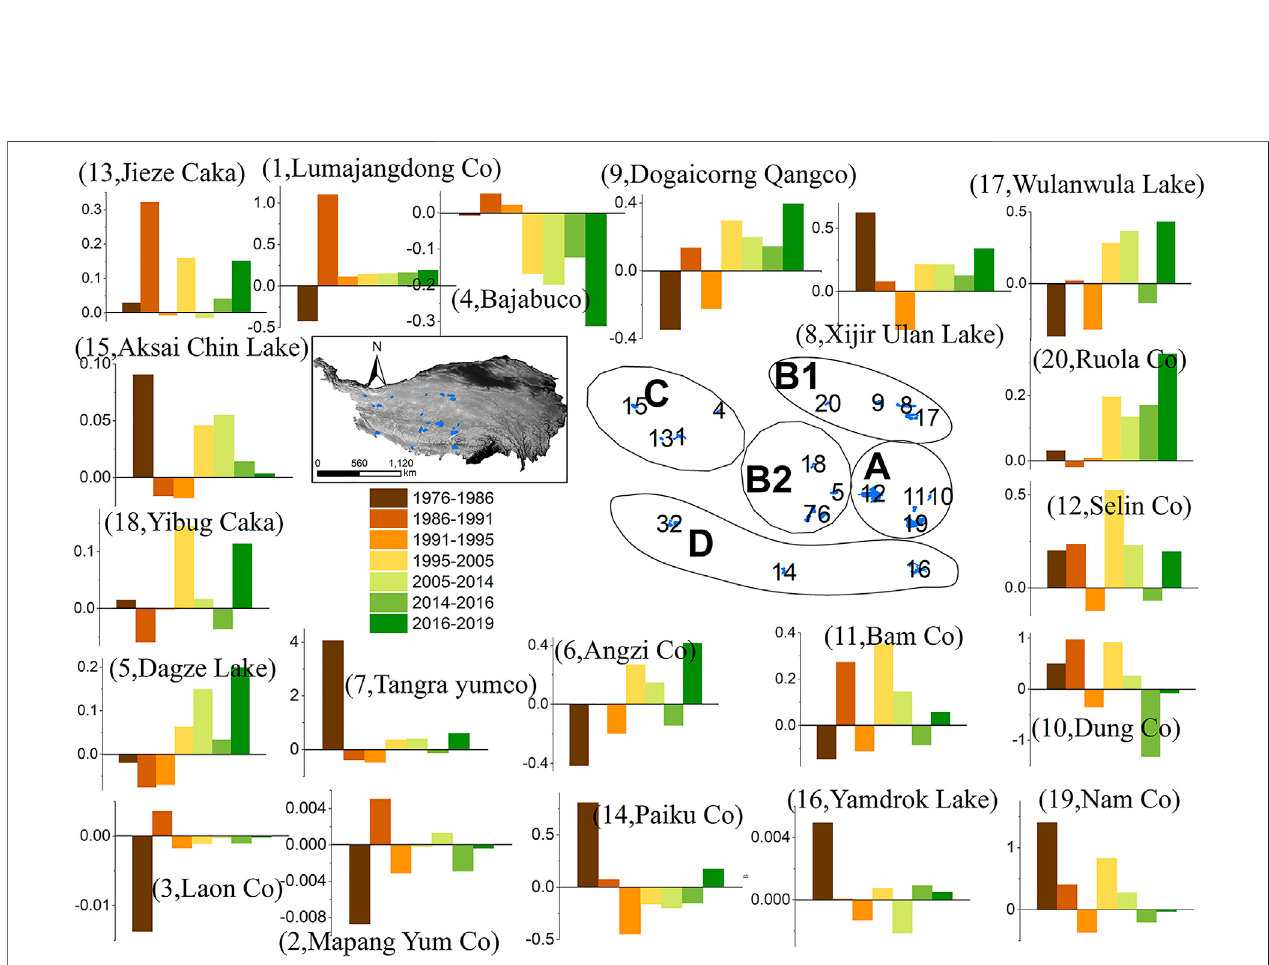
FIGURE 4 | Spatial distribution features of AAVCR_B for the 20 studied lakes in different periods during the period 1976 – 2019.